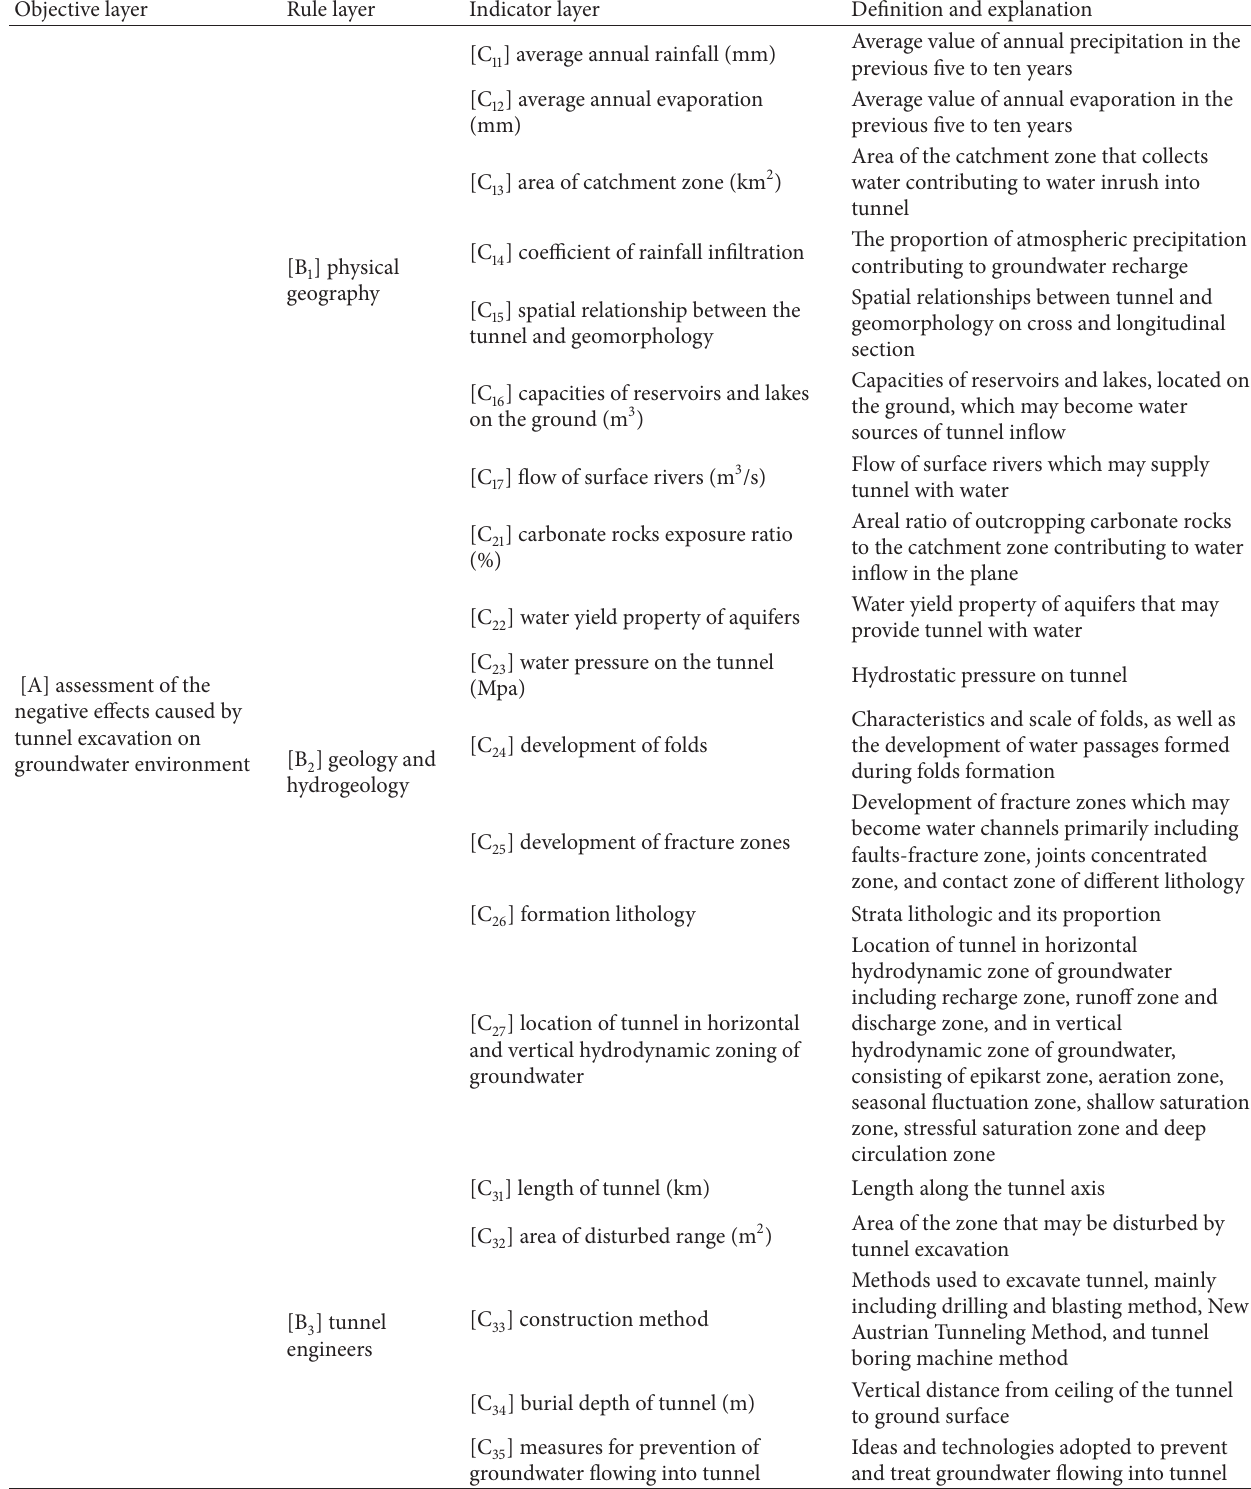
Table 1: Indicator system for assessment of the negative effects caused by tunnel excavation on groundwater environment [16]. Objective